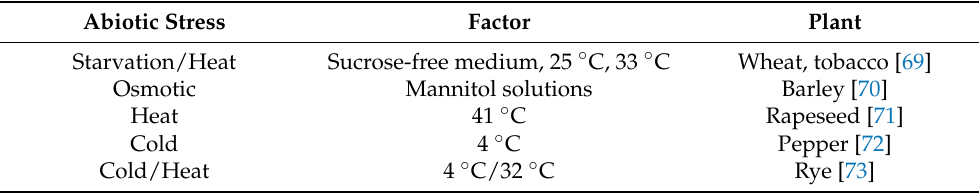
Table 2. Summation of stresses that efficiently switch the developmental fate of